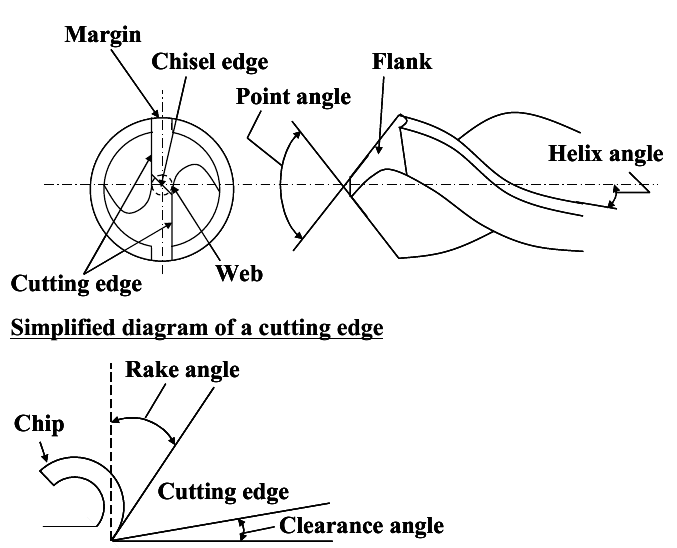
Fig. 1 Schematic drawing of a conventional twist drill showing the important functional design